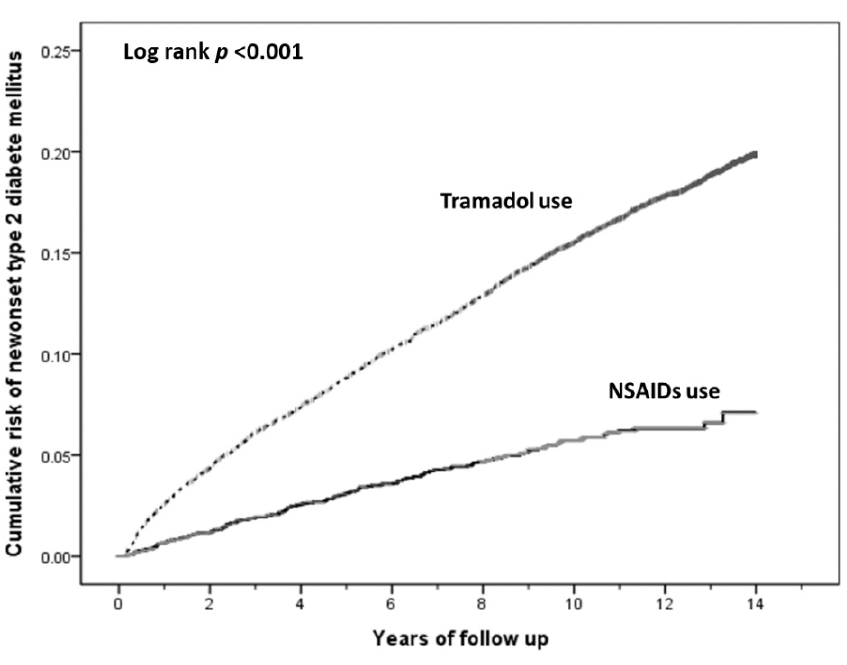
Figure 2. Kaplan-Meier curves for the cumulative risk of incident type 2 diabetes mellitus stratified by the use of non-steroidal anti-inflammatory drugs (NSAIDs) and tramadol with log-rank test. The stratified analyses based on subgroups formed by sex and age showed results Table 2. Association between administration of non-steroidal anti-inflammatory drugs (NSAIDs) that were consistent with the primary findings, namely, the existence of an inverse associa- and risk of type 2 diabetes mellitus (T2DM). tion between use of NSAIDs and risk of T2DM after adjusting for potential confounders. Adjusted HRs (95% CIs) were 0.30 (0.25–0.37) and 0.35 (0.27–0.46) for men and women, respectively, as well as 0.33 (0.19–0.55), 0.38 (0.31–0.48), and 0.26 (0.19–0.34) for those aged <40, 40–59, and (cid:61) 60 years, respectively (Table 3). Table 3. Association between the use of non-steroidal anti-inflammatory drugs (NSAIDs) and risk of type 2 diabetes mellitus (T2DM) stratified by sex and age.